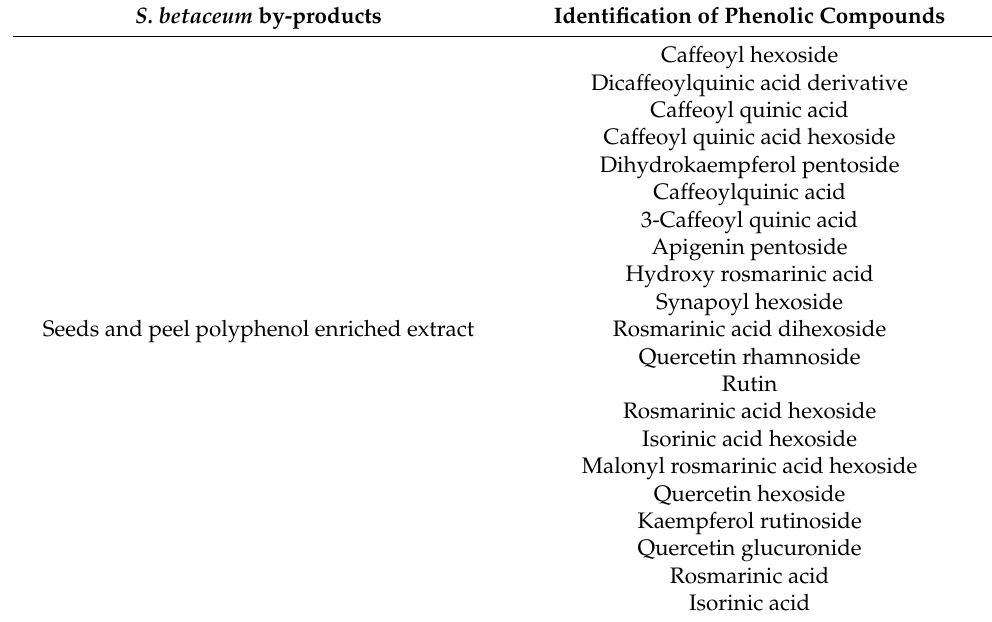
Table 4. Phenolic compounds identified in seeds and peel of S. betaceum fruits by HPLC